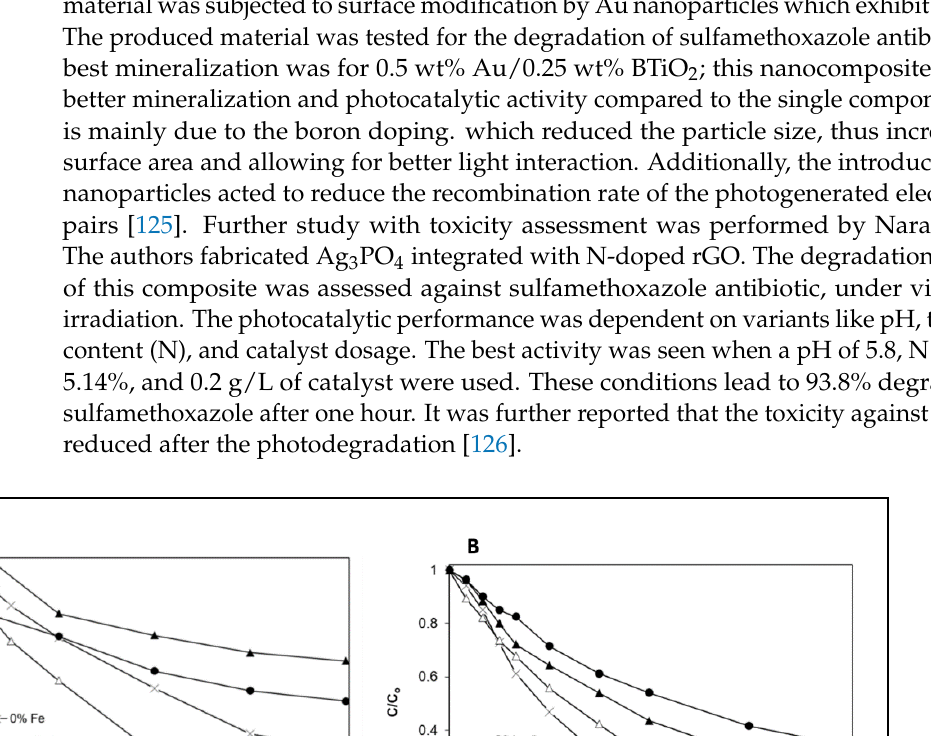
Figure 14. ( A ) Signifies the effect of iron doping level, where 0.5% Fe/TiO 2 showed the most efficient photocatalytic degradation. ( B ) represents the effect of initial SMZ concertation; as noted, there is a decrement in the rate constant as the concentration of SMZ increases. Adapted with permission from [123]. Copyright 2019